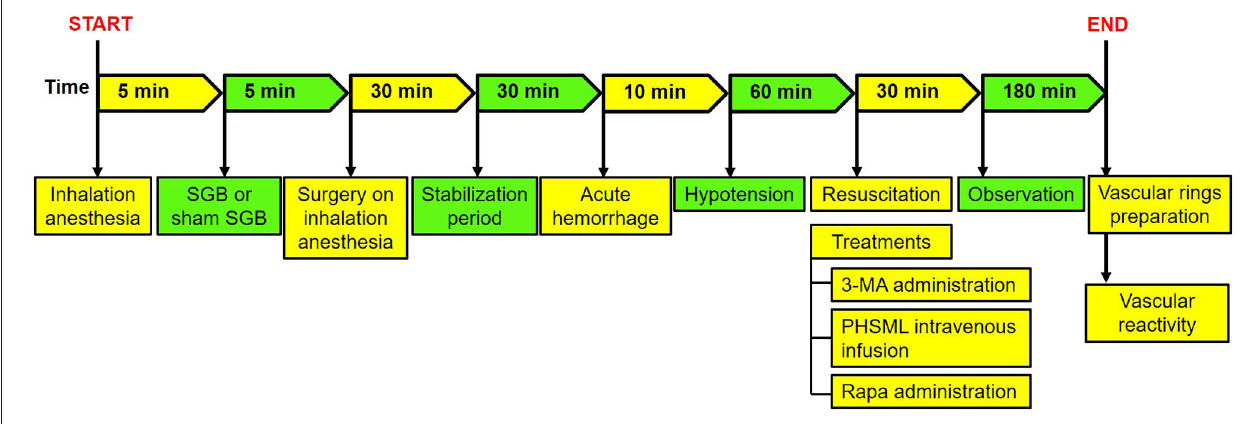
FIGURE 1 | The surgical procedure of hemorrhagic shock model in conscious rats. SGB, stellate ganglion block; PHSML, posthemorrhagic shock mesenteric lymph.